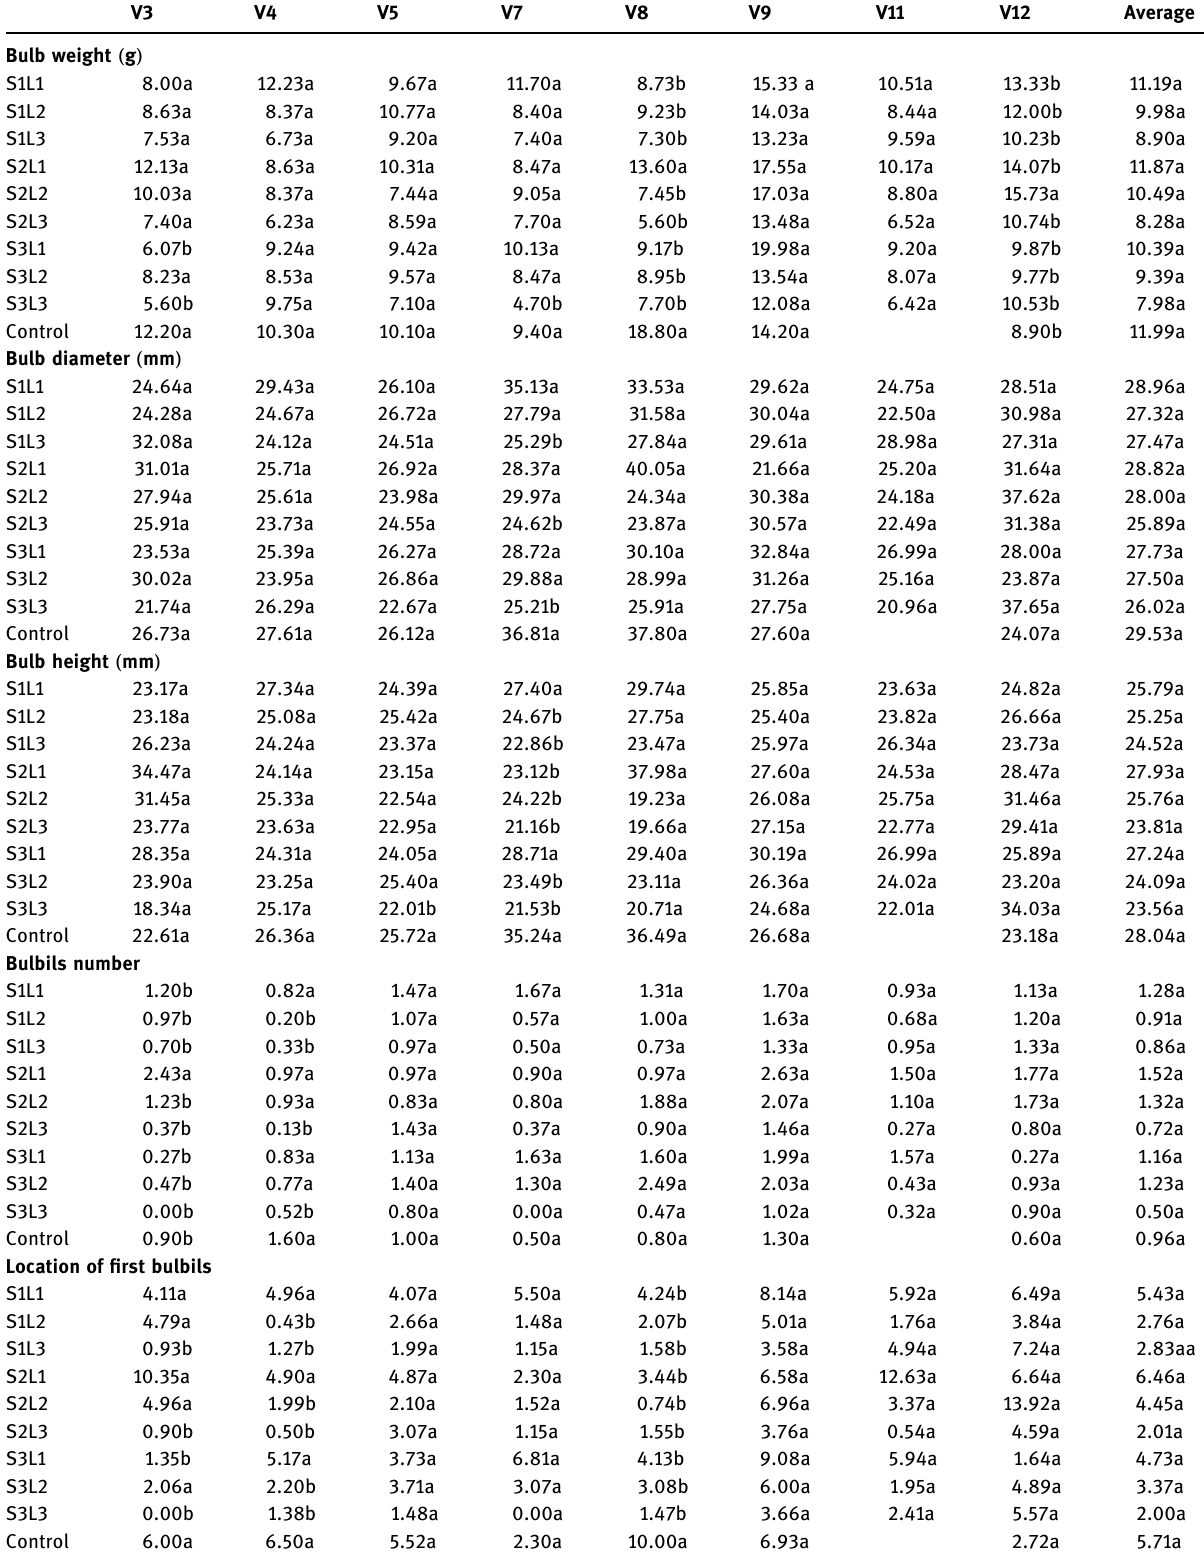
Table 5: Average number of bulb weight, bulb diameter, bulb height, bulbils number, location of fi rst bulbils, and cloves number of the garlic clones with vernalization temperature and vernalization